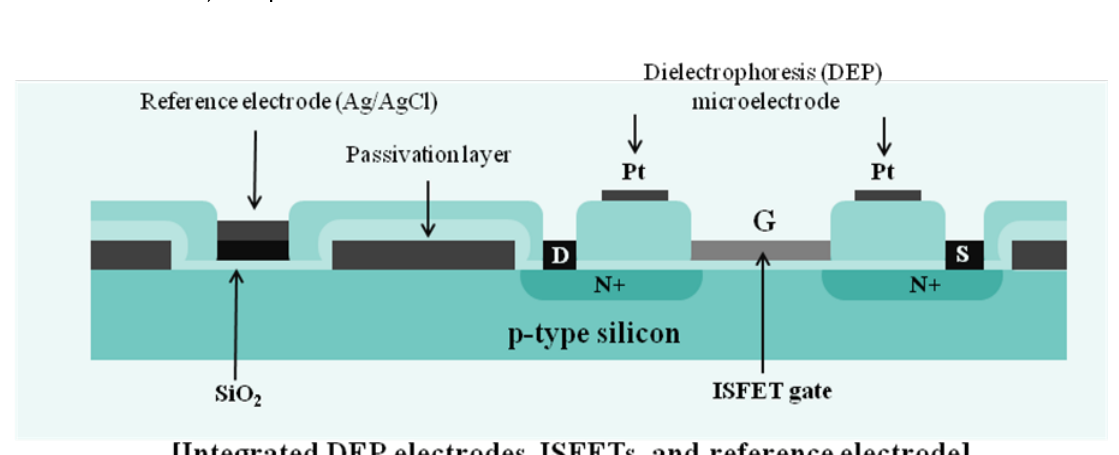
Figure 7. A cross-sectional diagram of the device showing the ISFET sensors, DEP microelectrodes, and pseudo-reference electrode